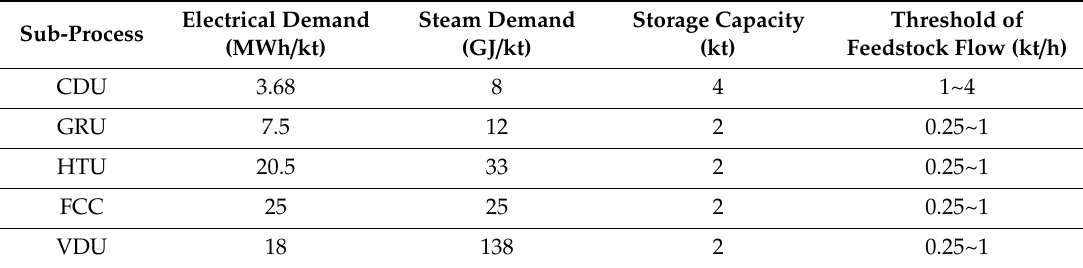
Table 2. Technical data of CHP and industrial boiler.